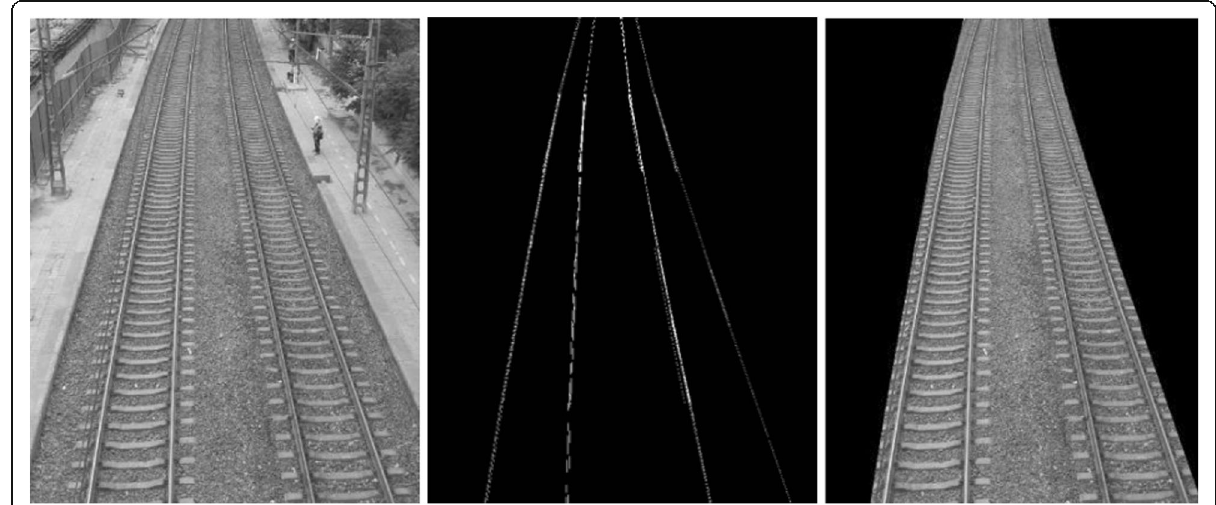
Fig. 6 Update process diagram of the monitoring area. a Video screenshot of the port transport corridor. b Identified rail edges. c Updated monitoring area